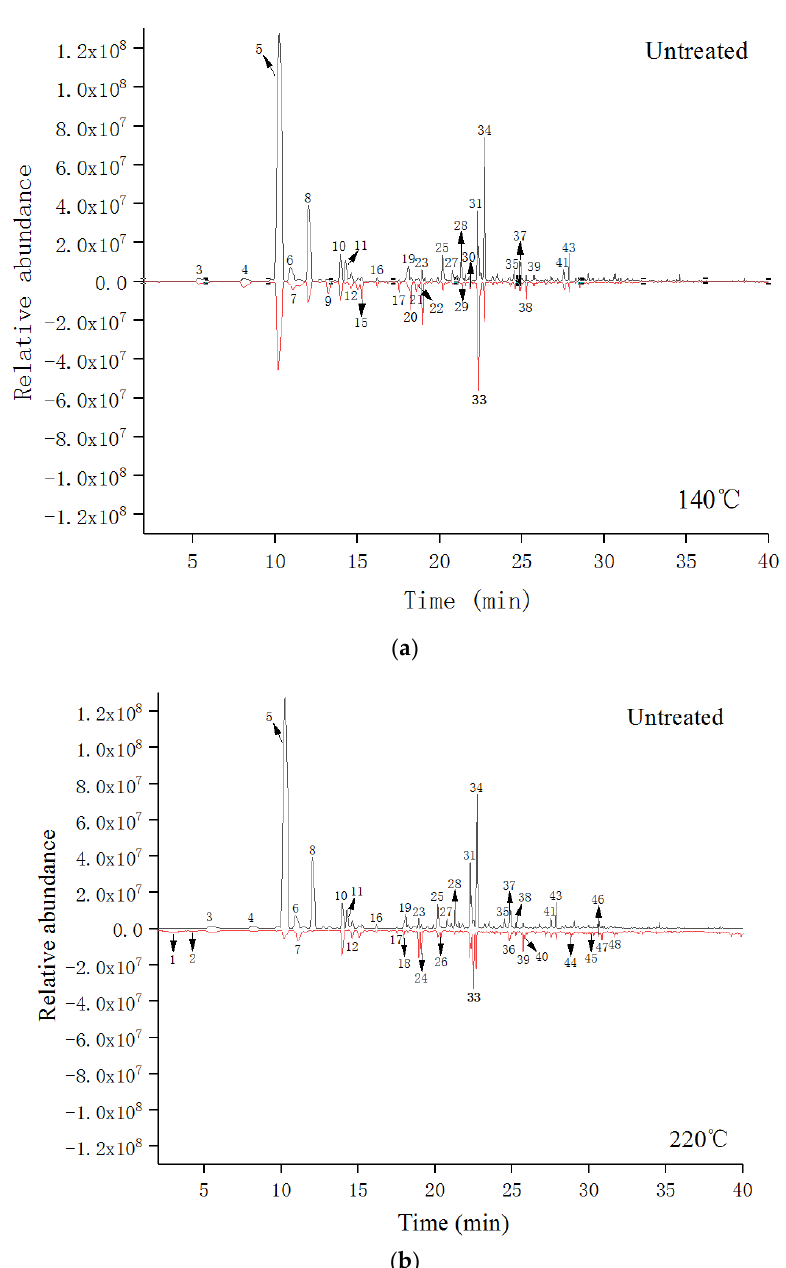
Figure 3. Gas chromatography-mass spectrometry (GC-MS) chromatograms of untreated southern pine and heat treated at 140 °C (a); untreated southern pine and heat treated at 220 °C (b). (peak numbers appear in Table 4).